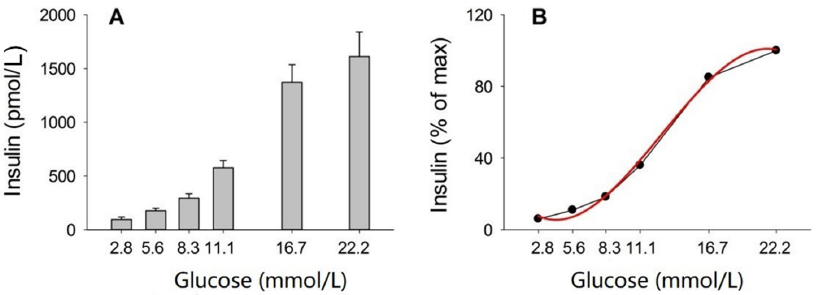
Figure 2. Insulin secretion from islets freshly isolated from C57BL/6J mice stimulated with the indi ‐ cated glucose concentration in static incubations for 60 min ( A ) and the relation with the best fit shown as the red line ( B ). Means ± SEM are shown in A. N = 8 in each glucose concentration, where n indicates number of studies during which eight incubations were undertaken with three islets in each.